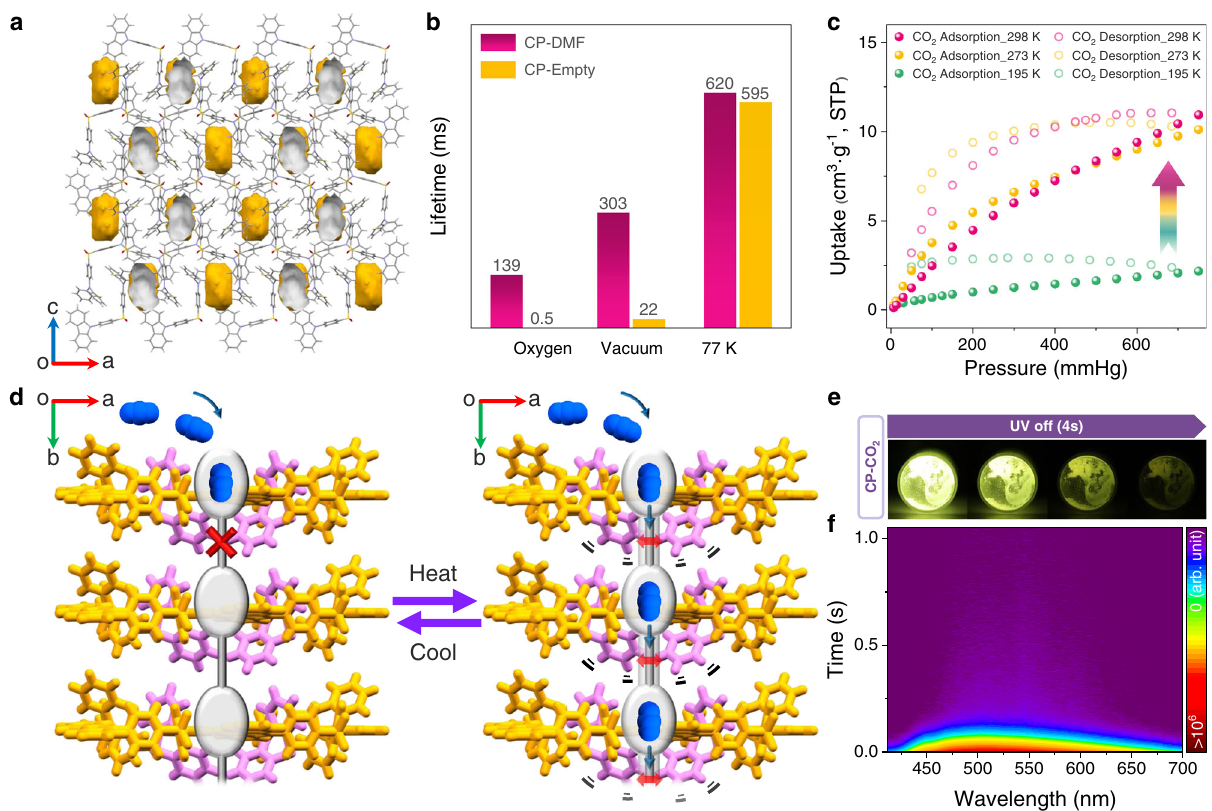
Fig. 4 | Investigation of relationship between molecular motion and dynamic URTP feature. a The single-crystal structure of CP-DMF along the b -axis, with the solvent-accessiblevoidspacevisualizedbygray/yellow(inner/outer)curvedplanes generatedwithaprobeof1.2Å.Colorcode:gray,C;red,O;blue,N;yellow,S;white, H.DMFmoleculesareomitted. b LifetimesofCP-DMFandCP-Emptycrystalsunder variousconditions. c CO 2 adsorption/desorptionisothermsforCP-Emptyatvarious temperatures. d Schematic diagram of void structures of the dish-like molecular